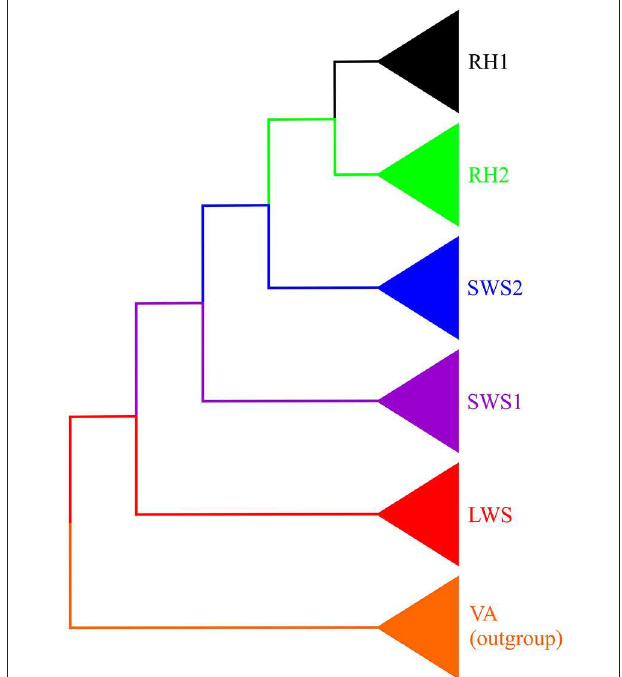
FIGURE 3 | Phylogeny of opsin-based photopigment genes. Vertebrate ancient (VA) opsin (orange) was used as an outgroup. The diagram depicts the relationships among four cone photopigments: long-wavelength-sensitive (LWS) opsin (red), short-wavelength-sensitive 1 (SWS1) opsin (purple), short-wavelength-sensitive 2 (SWS2) opsin (blue) and rhodopsin-like 2 (RH2) opsin (green), as well as the rod (RH1) opsin